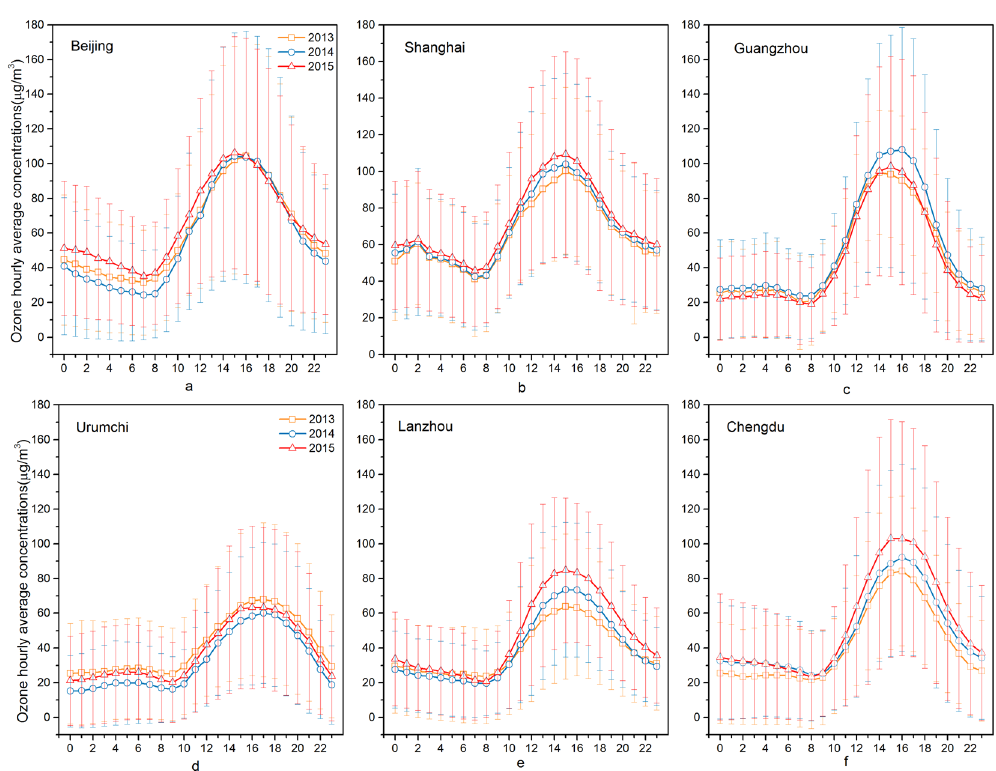
Figure 12. Hourly distribution of the maximum daily eight-hour average (MDA8) concentrations of ground- level ozone concentrations in six cities during